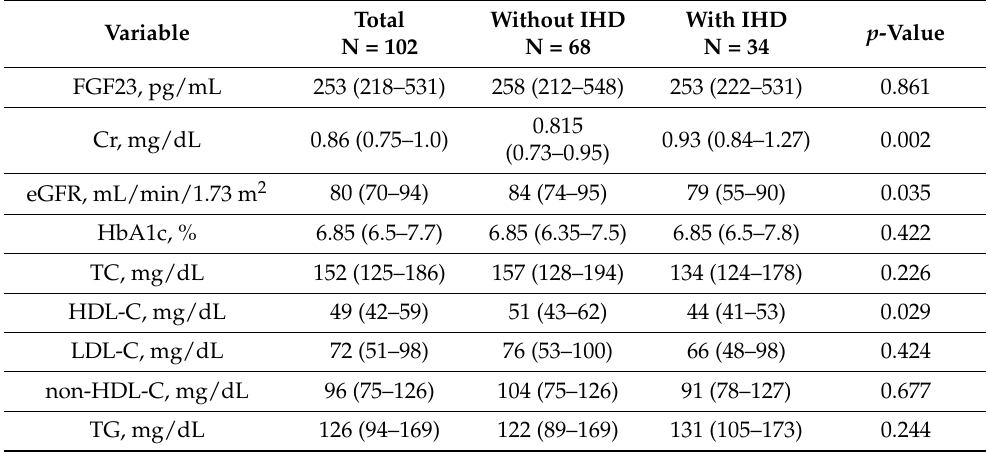
Table 2. Laboratory test results.